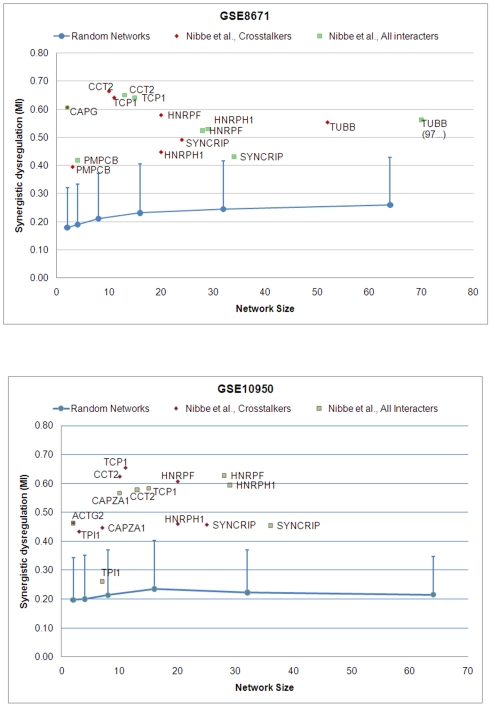
Synergistic dysregulation versus network size for candidate sub-networks associated with proteomic seeds obtained from Nibbe et al.Sub-network dysregulation (i.e. mutual information of sub-network mRNA expression profile with phenotype class) versus network size for candidate sub-networks. All interactors (green squares) and crosstalkers (red diamonds) were scored using (a) GSE10950 and (b) GSE8671. The blue lines represent the linear interpolation of the means of the estimated null distributions computed for random candidate sub-networks of size 2,4,8,16,32, and 64, using the respective arrays (see Materials and Methods for details). Vertical bars represent one standard deviation from the mean.